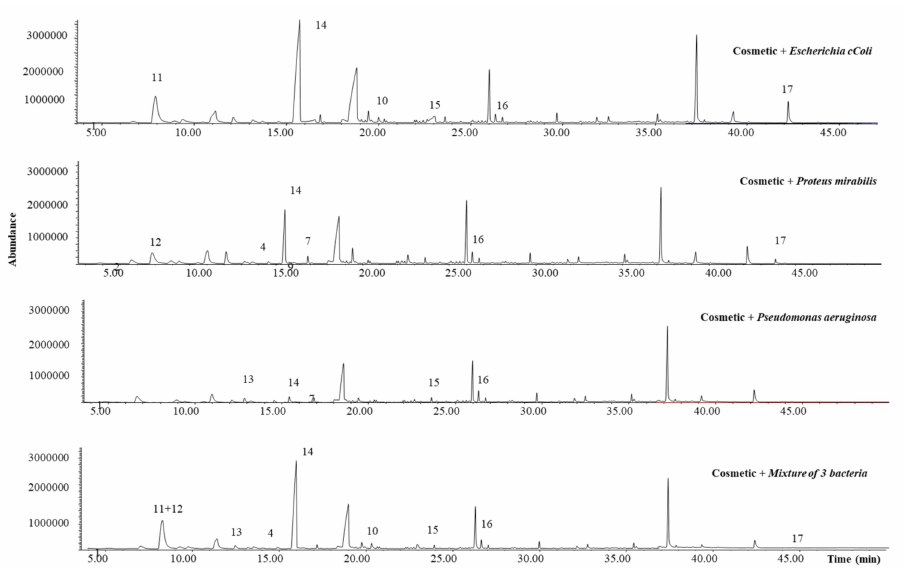
Figure 7. Identified MVOCs in the obtained SPME-GC-MS chromatograms after cosmetic